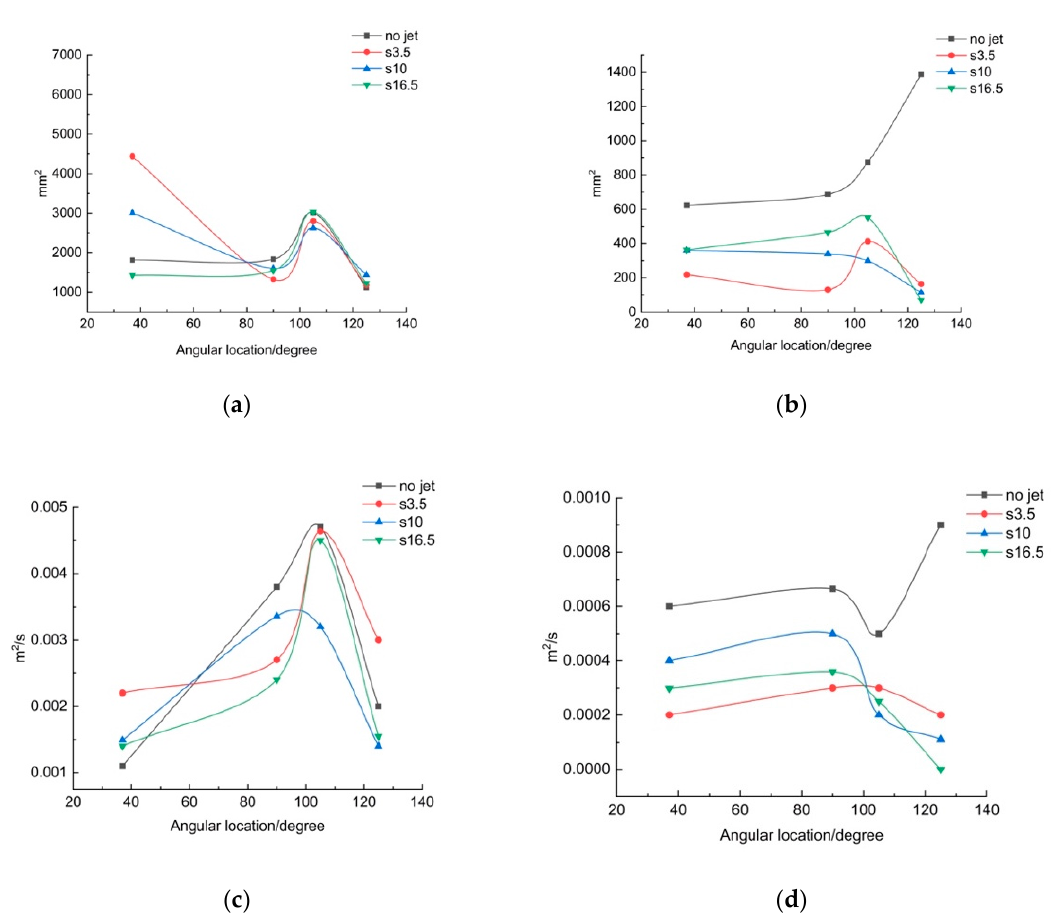
Figure 9. Secondary flow property evolution with respect to jet salinity in the bend: ( a ) center region cell size; ( b ) outer bank cell size; ( c ) center region cell vorticity; ( d ) outer bank cell vorticity.